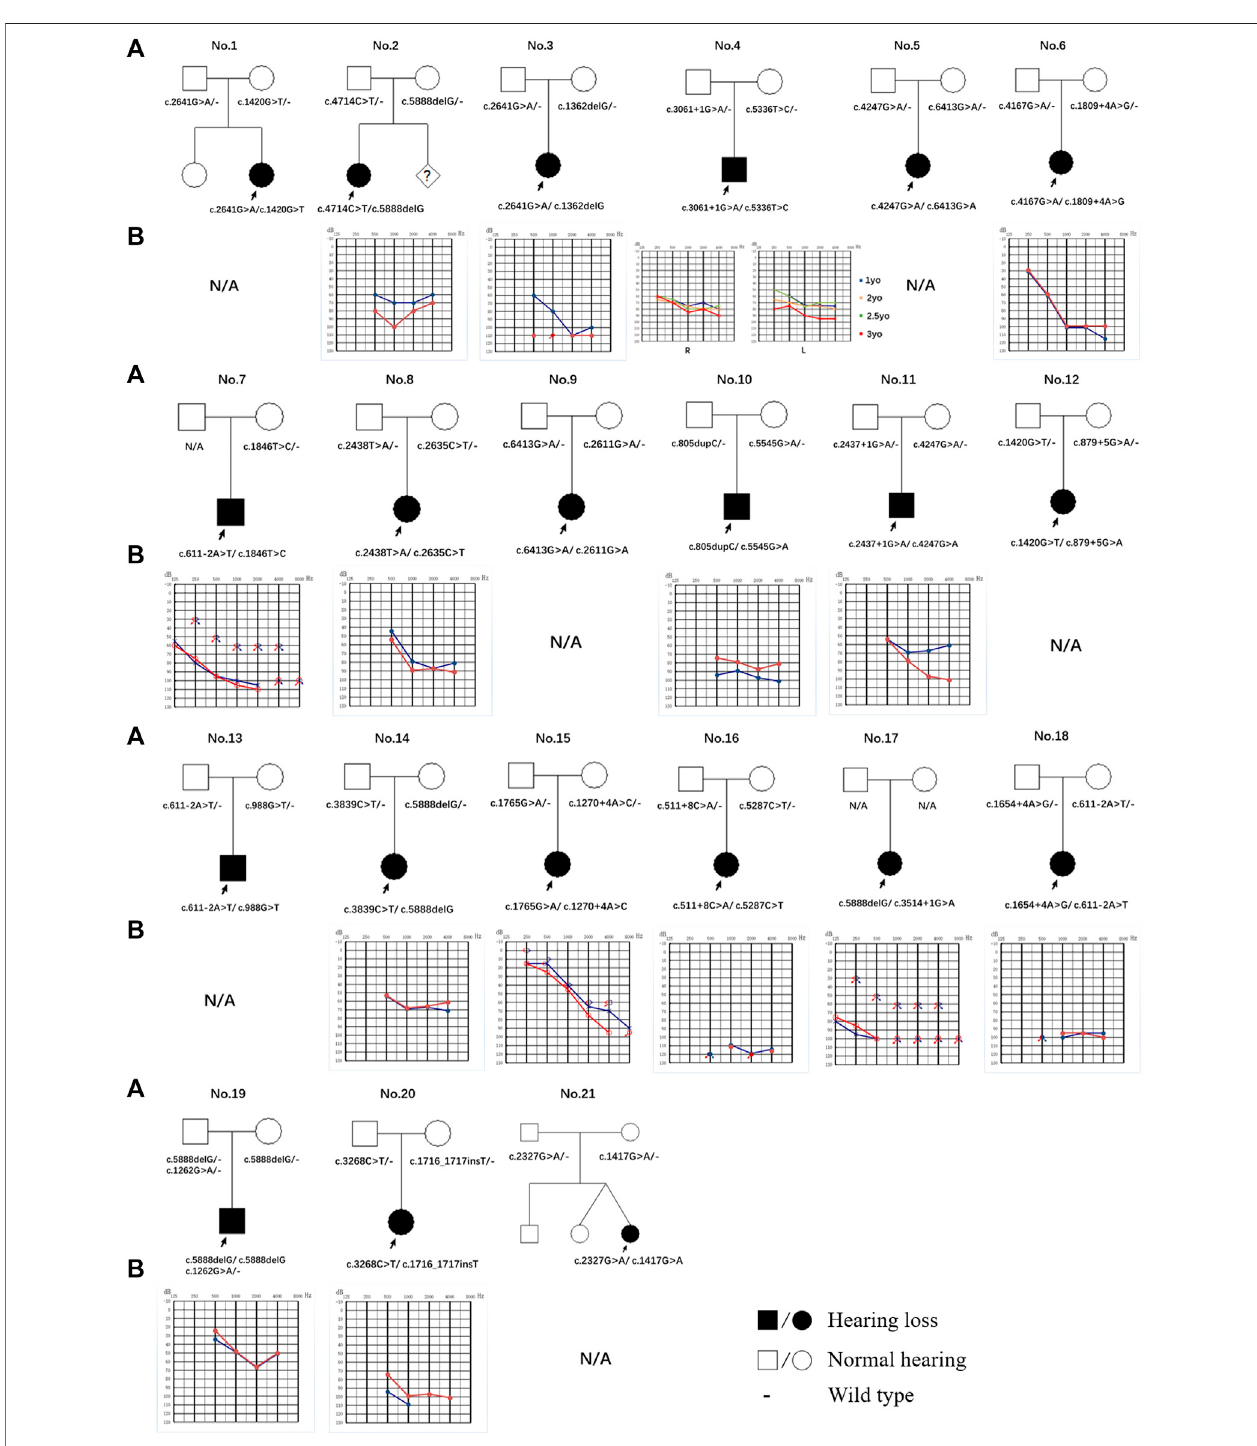
FIGURE 1 | Pedigree and audiogram of families with LOXHD1 causatives. (A) Affected subjects are denoted in black. The proband is indicated by an arrow. (B) Audiograms of the affected subjects. (red, right ear; blue, left ear).